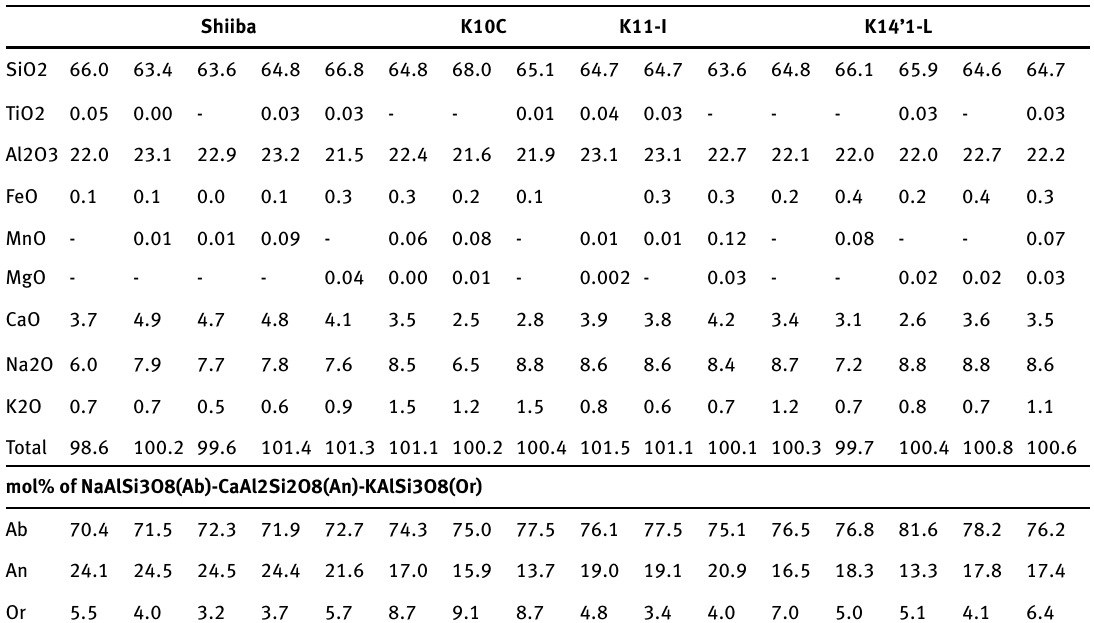
Table 4. Chemical compositions (wt.%) of feldspar microlites in the Kyushu obsidians. Shiiba K10C K11-I